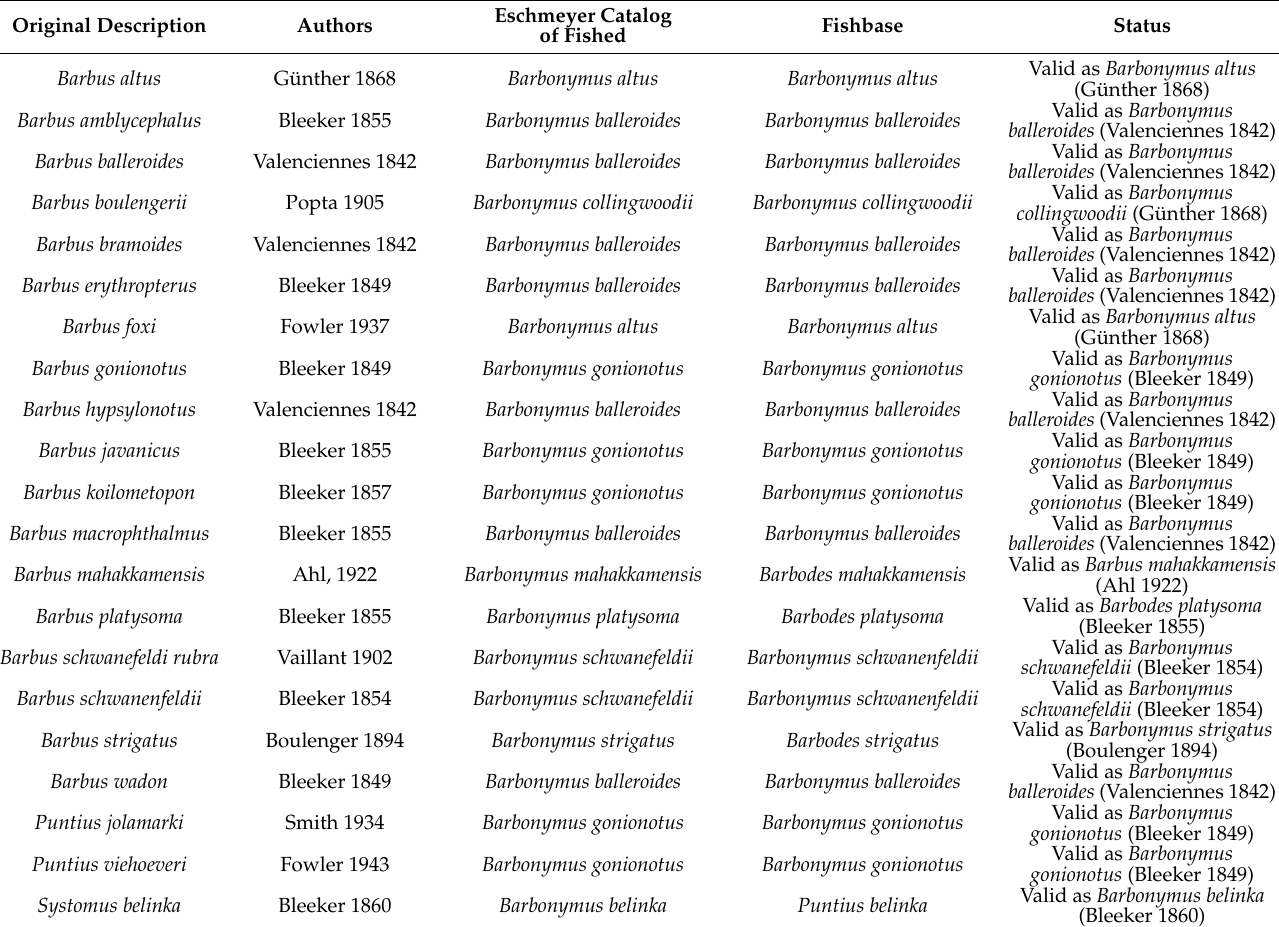
Table 1. List of available nominal species of Barbonymus including species names in original descriptions, authors, species names in Eschmeyer’s Catalog of Fishes and Fishbase, and current status following